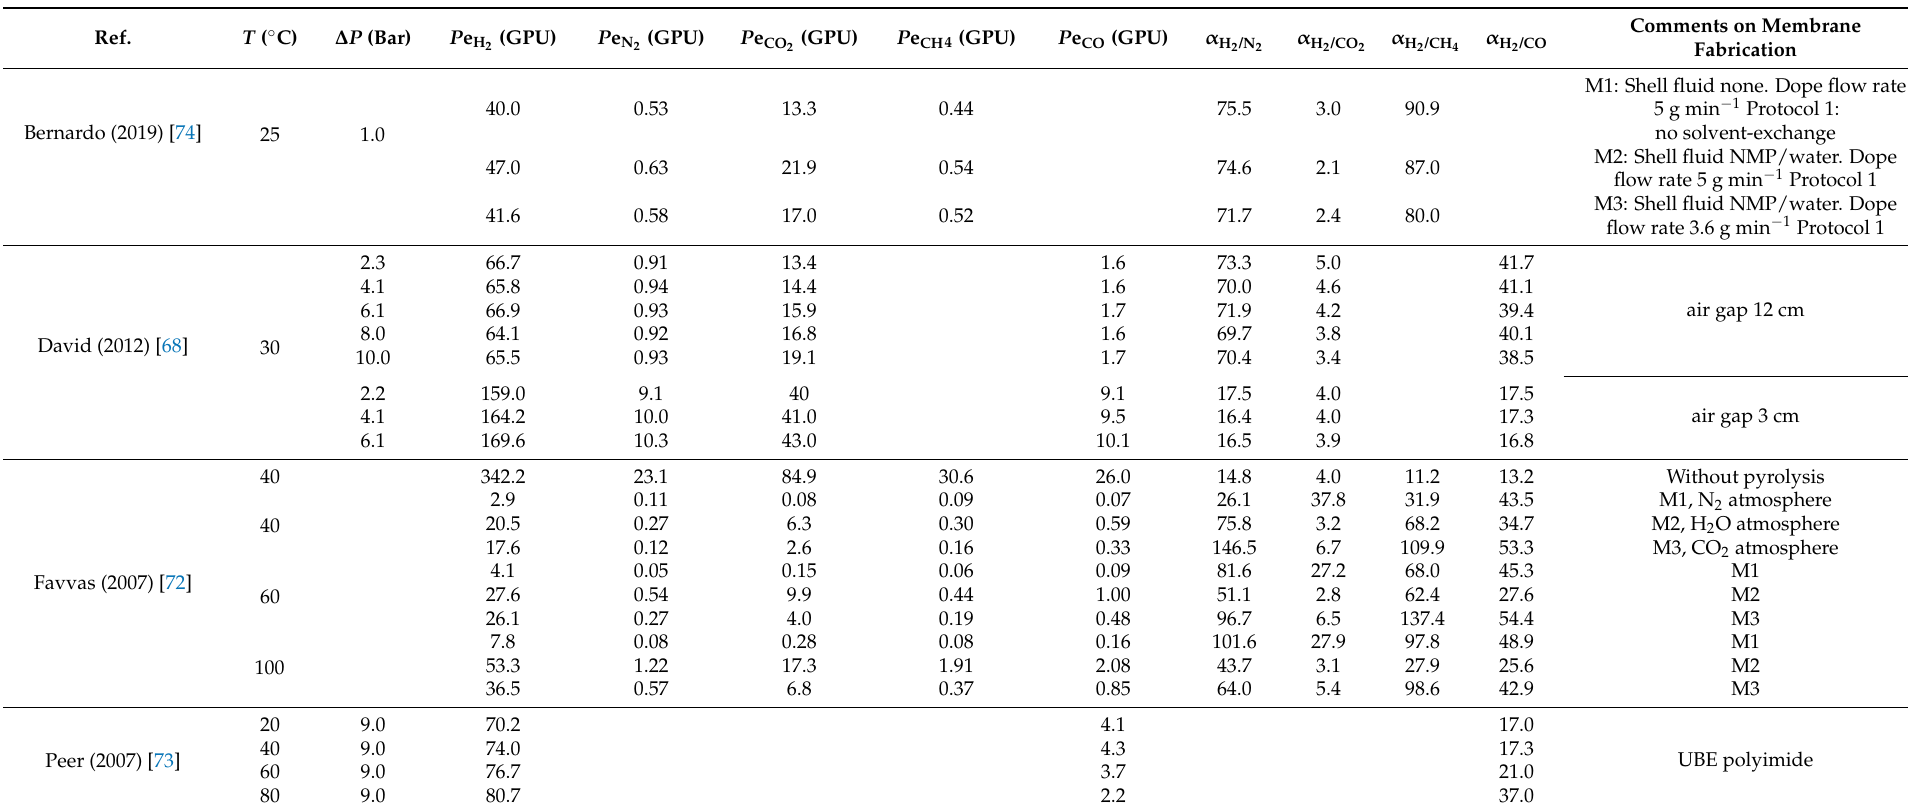
Table 3. Main bibliographical data in terms of pure gas H 2 , N 2 , CO 2 , CH 4 and CO permeance (Pe) and selectivities through Matrimid ® HFMs.